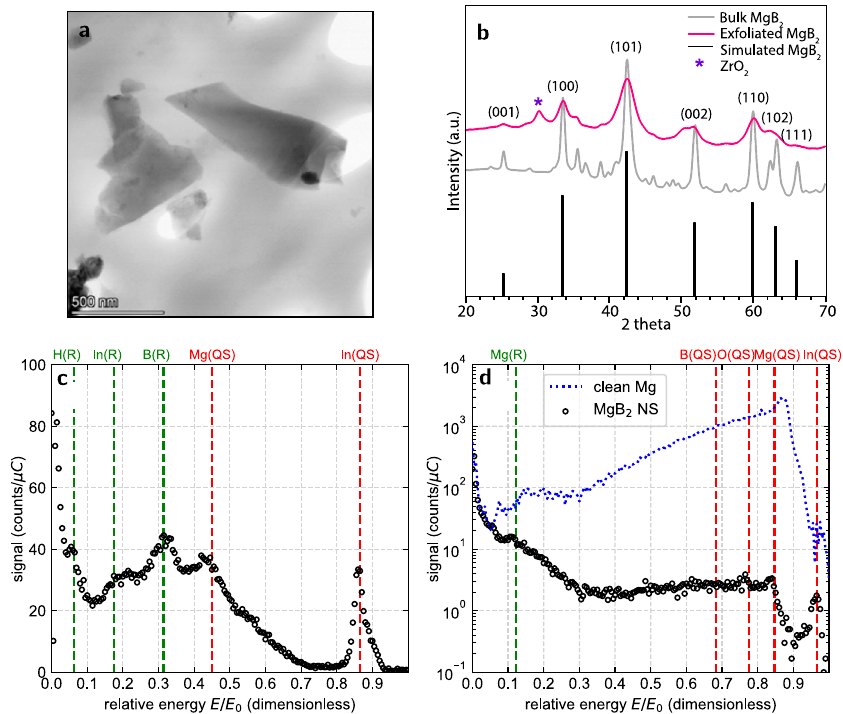
Fig. 4 Physical and chemical characterization of the exfoliated MgB 2 NSs. a Representative TEM image of the exfoliated MgB 2 NSs. b XRD analysis of bulk or standard MgB 2 and exfoliated MgB 2 NSs, compared with simulated MgB 2 diffraction data. A small peak at 30.4 ∘ corresponds to zirconia (ZrO 2 ) contamination obtained during high-energy ball milling (HEBM) of MgB 2 . c Ion energy spectrum for 3 keV Ne + on the MgB 2 NSs for α = 76 ∘ and θ = 54 ∘ . Scattering peaks are labeled X(QS) in red, while recoil peaks are labeled X(R) in green, to denote scattering or recoiling a surface atom of species X. The ion energy spectrum reveals a sizeable B(R) peak, evidence that boron is at the MgB 2 NS surface. d Ion energy spectrum for 3 keV He + on MgB 2 NSs is plotted as open black circles for α = 76 ∘ and θ = 60 ∘ . For illustrative comparison, a second ion energy spectrum for 2 keV He + on a clean Mg surface (for θ = 55 ∘ ) is shown as a blue dotted line. The higher-energy scattering peaks for the MgB 2 NSs are greatly suppressed by a matrixing effect. Note that a small shift in the relative energy of the Mg(QS) peaks between the two spectra is expected due to the slightly different scattering angle θ